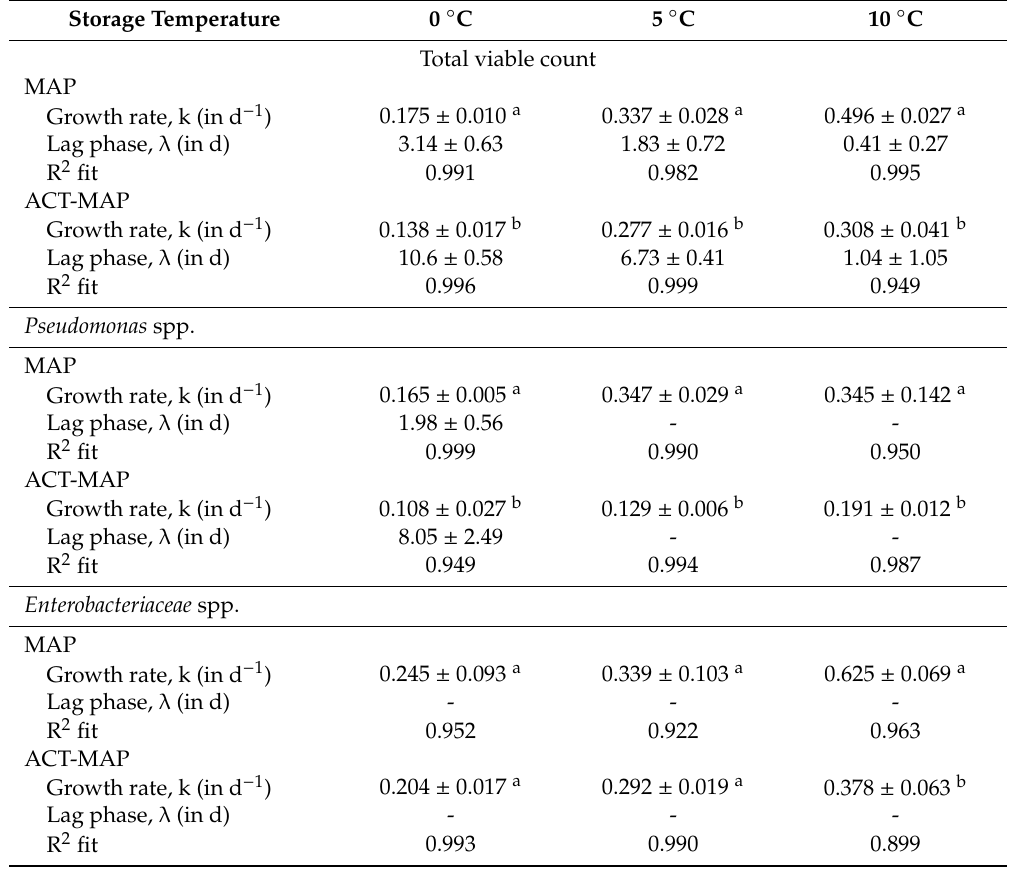
Table 1. Growth kinetic parameters (growth rate, k in d − 1 ; lag phase, λ in d), for the total viable count, Pseudomonas spp. and Enterobacteriaceae spp. in gutted sea bass during the isothermal storage at 0–10 ◦ C.